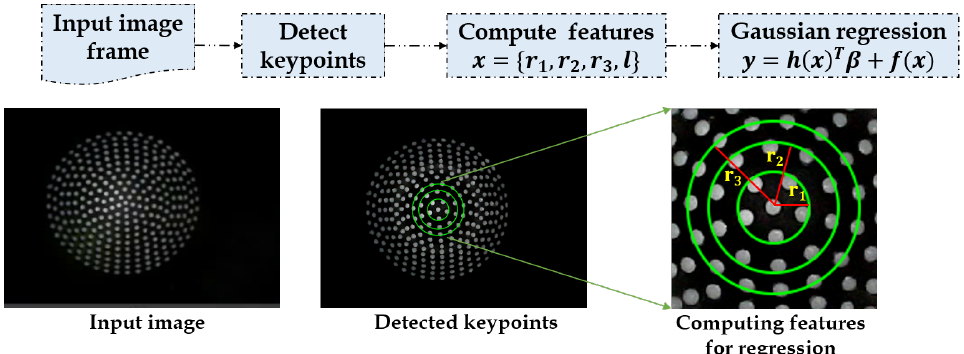
Figure 11. Flow schematic of 2D contact area estimation